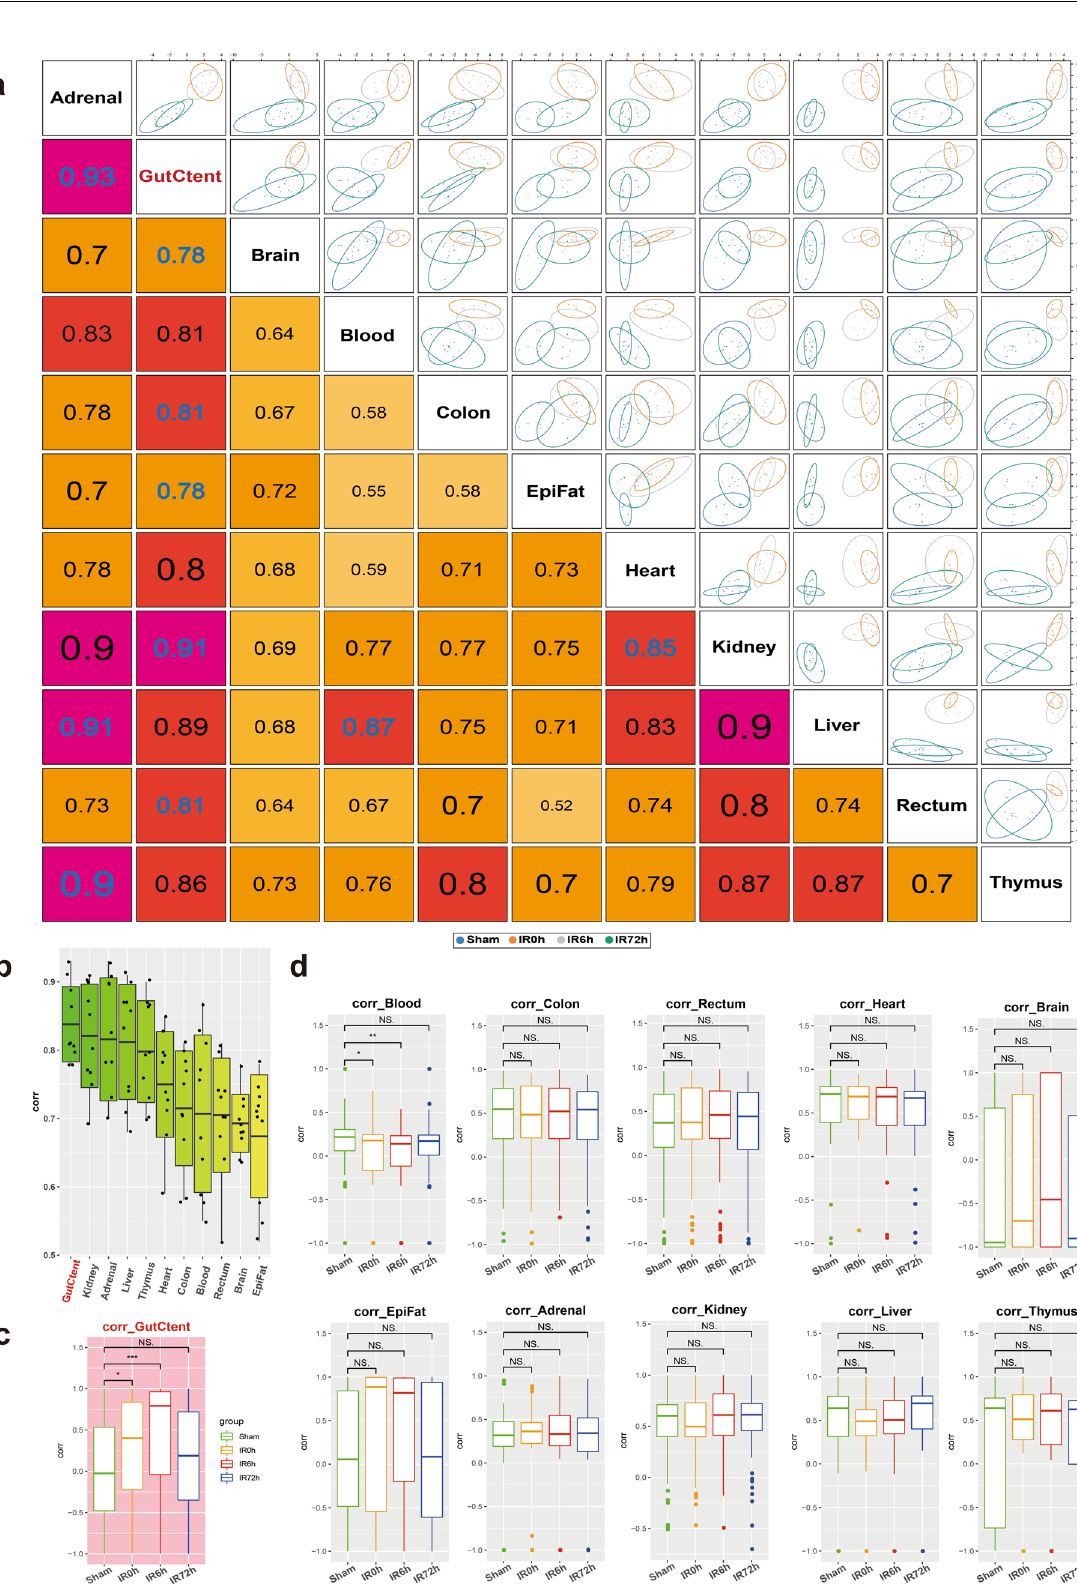
N -(omega)-Hydroxyarginine is an intermediate in the biosynth- esis of nitric oxide from L -arginine 37 . They are both linked to nitric oxide, which is a signaling molecule in the nervous system 38 . 5-Aminopentanoic acid is a methylene homolog of gamma-aminobutyric acid, an inhibitory neurotransmitter in